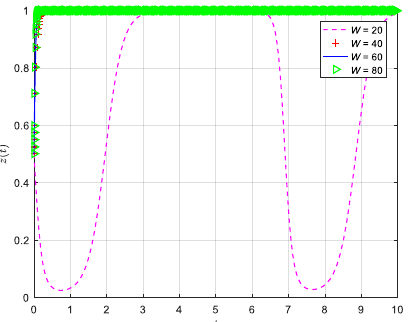
Figure 11. The impact of different fines W on the government.